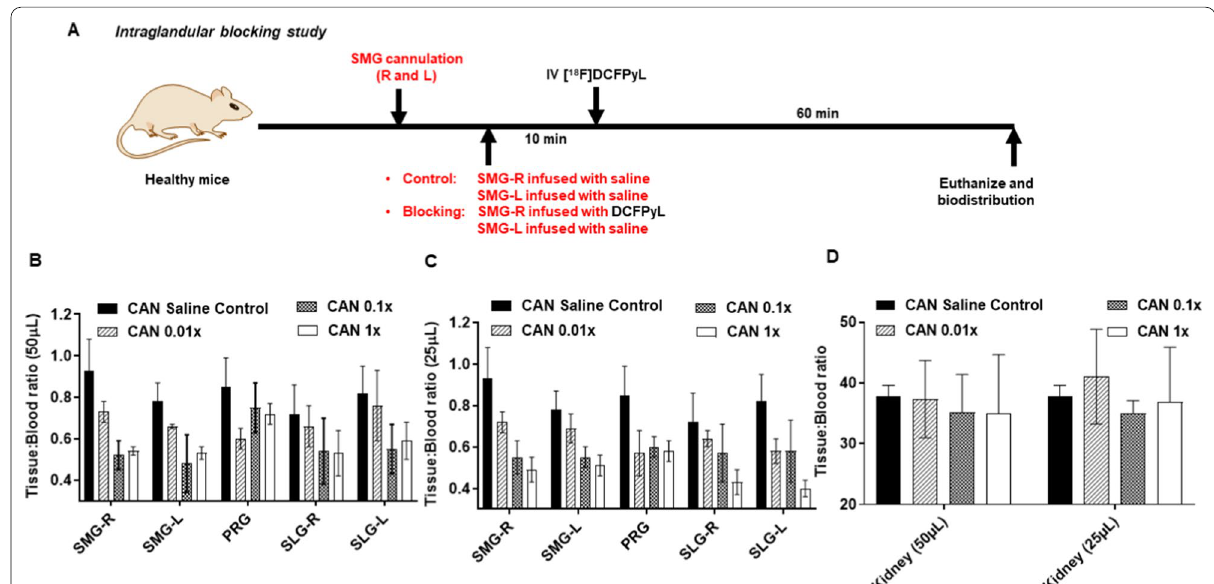
Fig. 4 a Experiment design for intraglandular blocking study. b , c Tissue/blood ratios of [ 18 F]DCFPyL in salivary glands (submandibular: SMG, sublingual: SLG, parotid: PRG, right: R, left: L; b and kidneys ( c ) at 1 h after injection. SMG glands were cannulated infused either with saline (CAN saline control) or with 25 µl or 50 µl of DCFPyL at 0.01, 0.1, 1 molar excess of the systemically injected “hot” [ 18 F]DCFPyL dose. Ten minutes after × SMG infusion, mice were injected with [ 18 F]DCFPyL. Each value in the graph represents mean tissue/blood